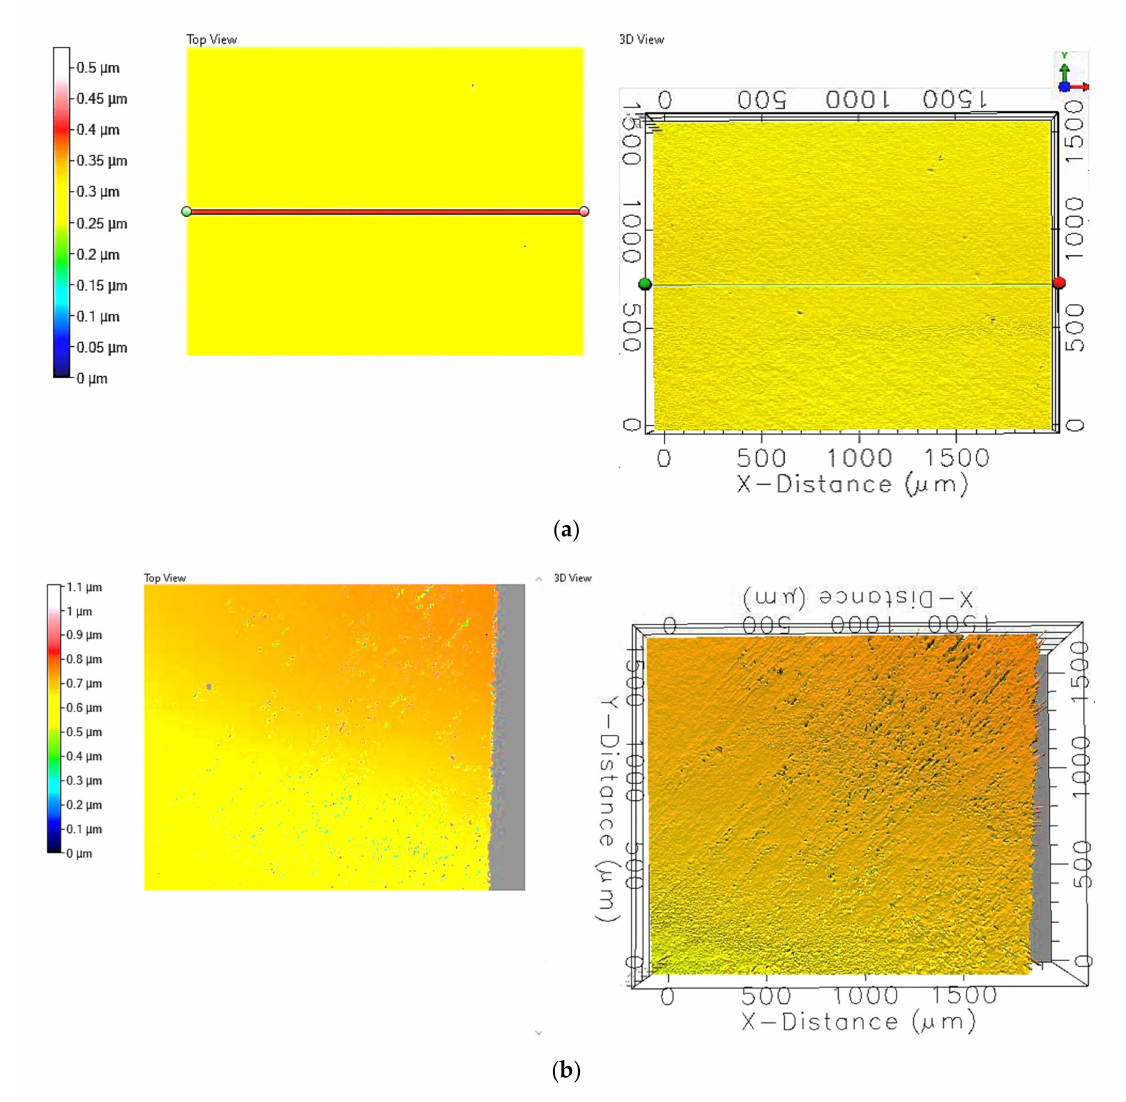
Figure 4. Surface of 50%ZnO50%Ta 2 O 5 thin film ( a ) before and ( b ) after corrosion in nitric